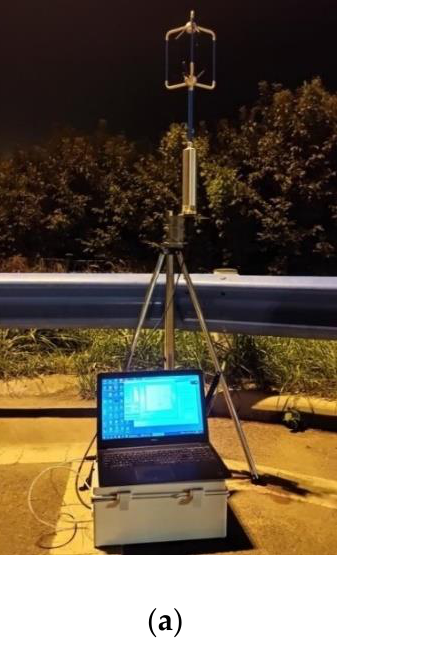
Figure 6. Ultrasonic anemometer ( a ) to measure the speed and direction of natural wind and its probability distribution ( b ).